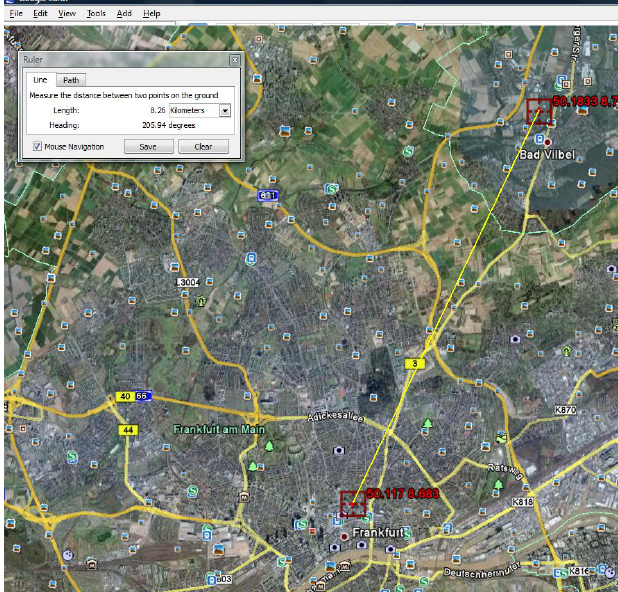
Figure 12. TWC ( α ), the possible outbreak source, on Google earth at the Long 8.683 and Lat 50.117 and its distance from the Erlenbach